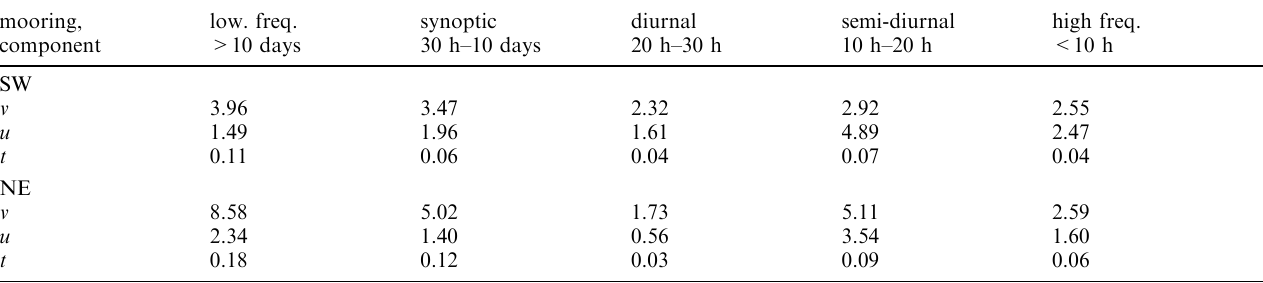
Table 2. Standard deviation of current components and temperature time-series filtered into 5 frequency bands. Current values are in cm s ) 1 and temperatures (cid:176) C mooring, component